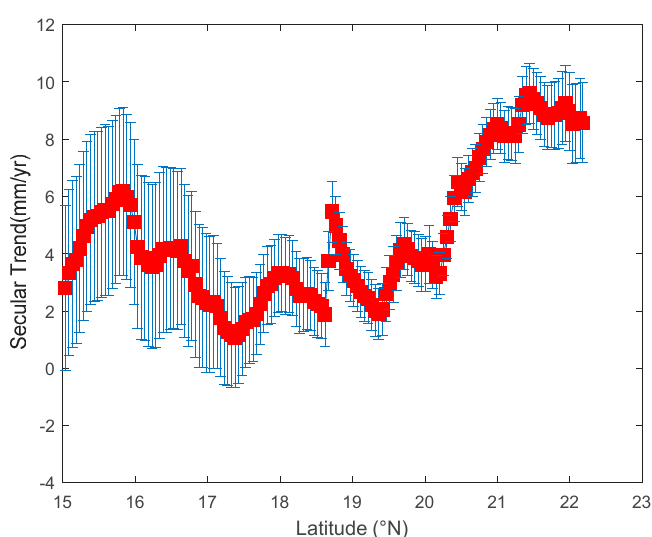
Figure 9. Regional 6.5 yr-long trends in sea level derived from filtered X-TRACK data along the Jason-2 pass 153. Vertical blue bars represent the uncertainty on the trend estimation.